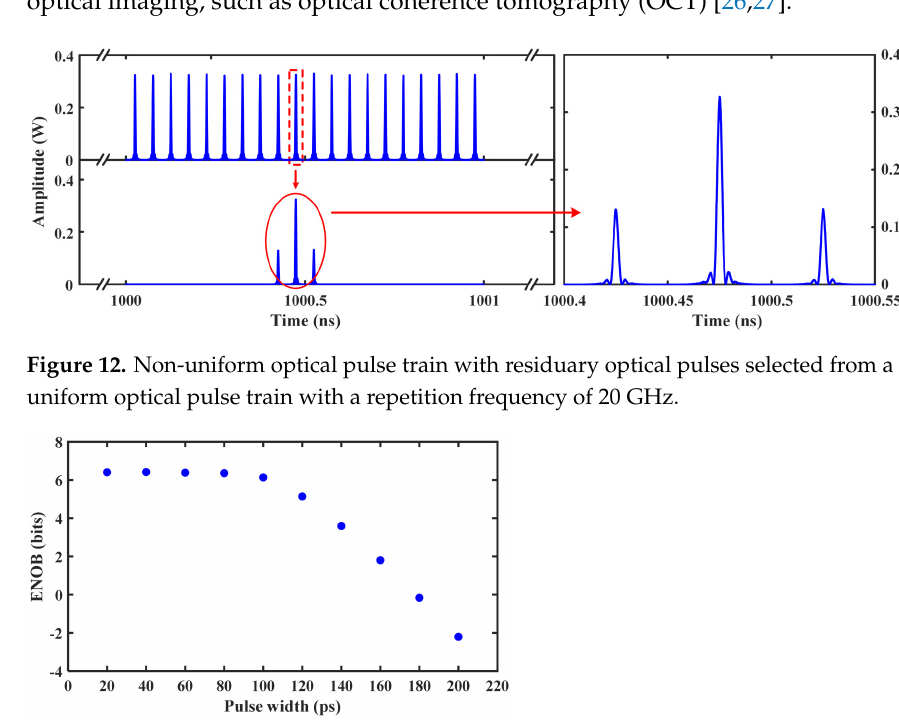
Figure 13. ENOBs of the NPS-based ADC under different pulse widths from the